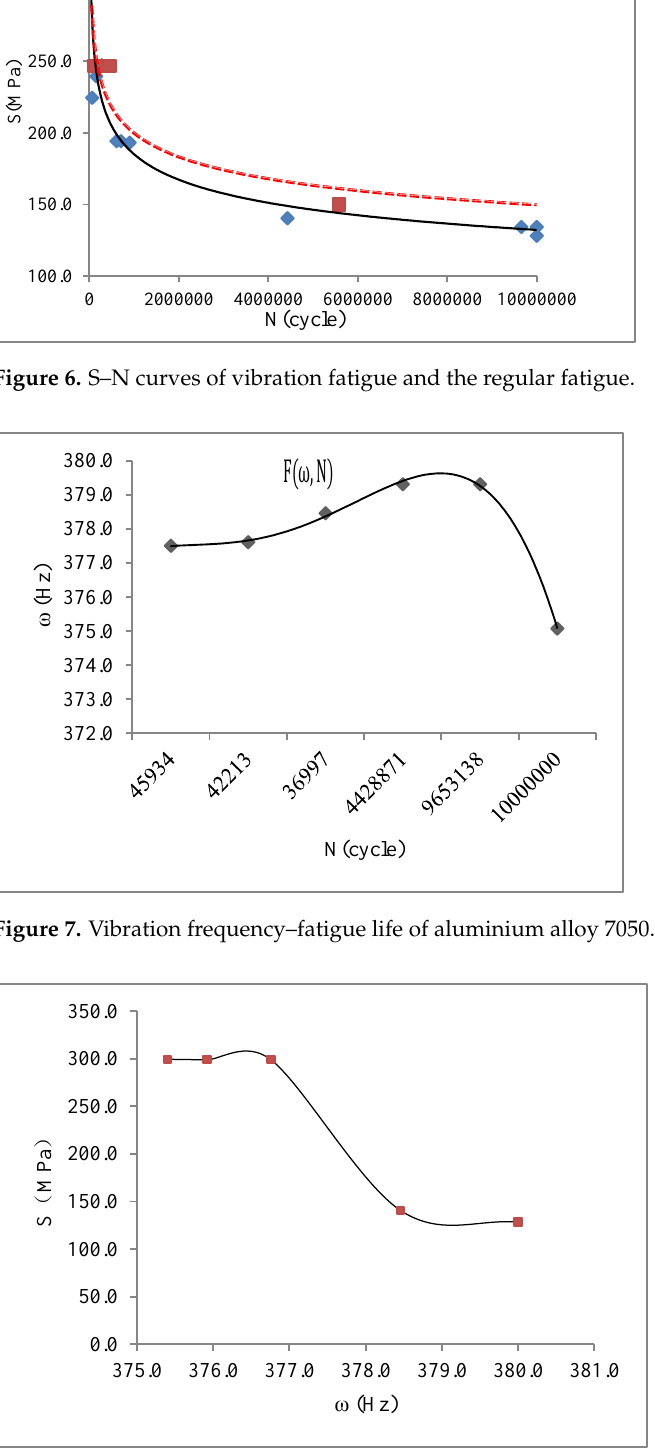
Figure 6. S – N curves of vibration fatigue and the regular fatigue.